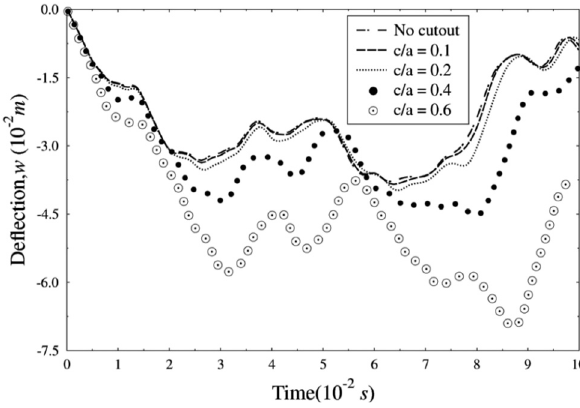
Figure 11: Linear dynamic time histories of CNTFPC fl at panels for di ff erent central cutout sizes.